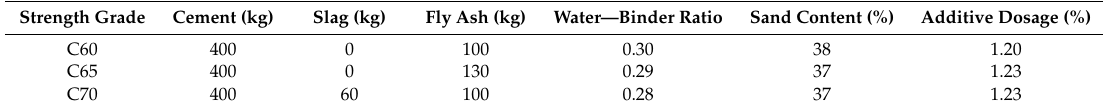
Table 2. Mix ratios for concrete to be pumped into the shaft lining.